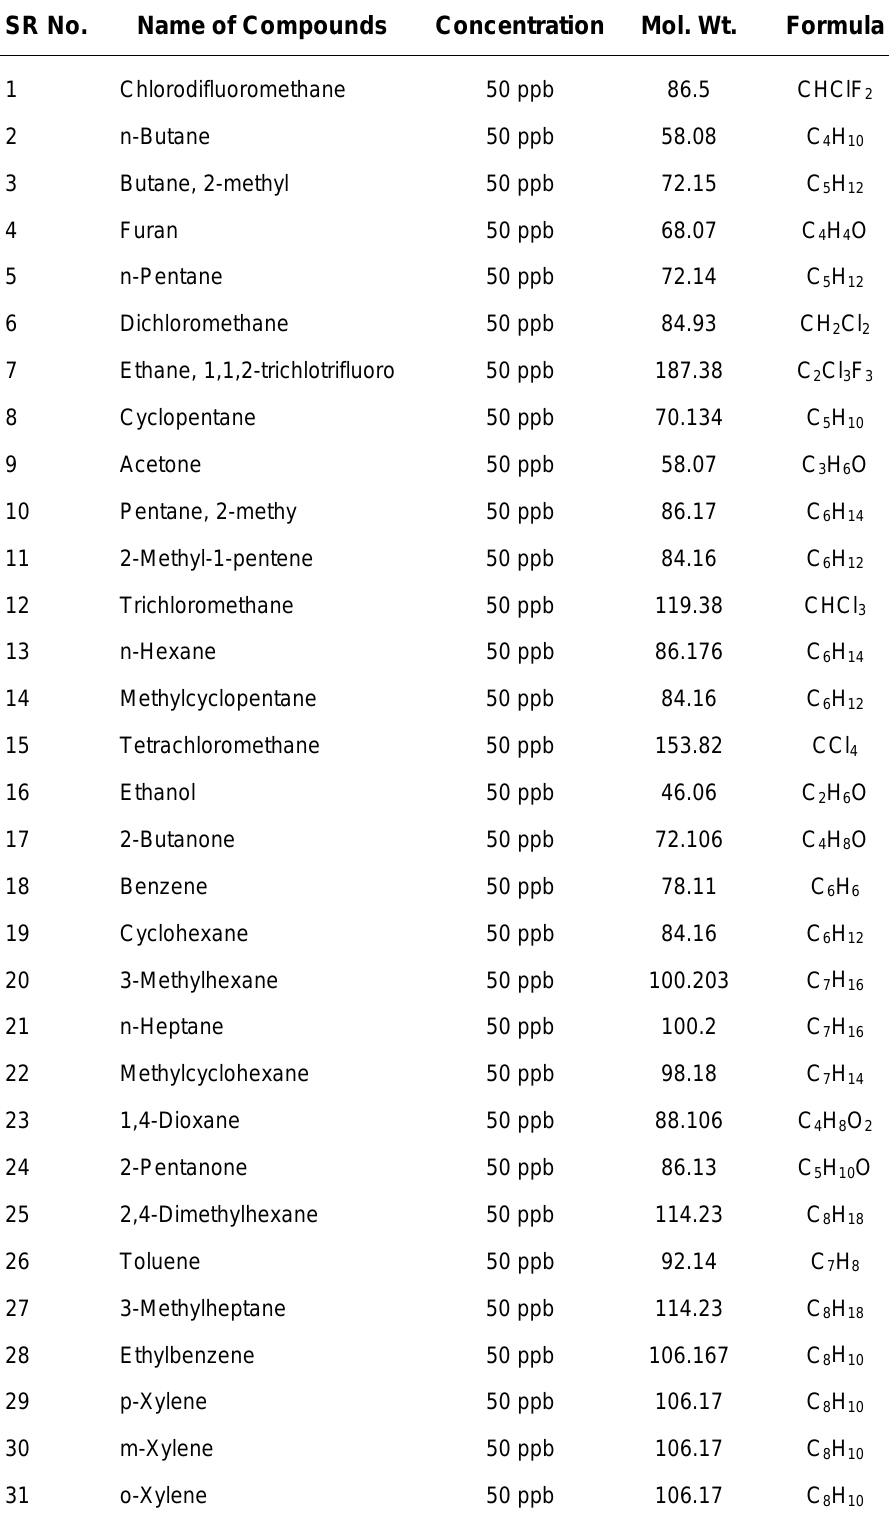
List of VOC Concentrations (Volume Fraction) in the Standard Mixture SR